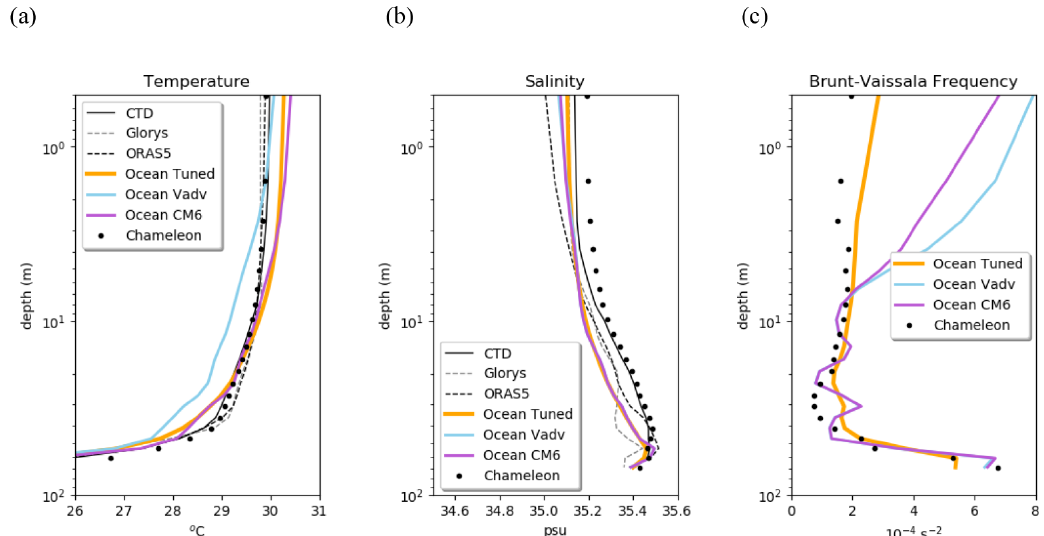
Figure 3. Mean vertical profile of (a) temperature ( ◦ C), (b) salinity (psu), and (c) the Brunt–Vaïsala frequency (10 − 4 s − 2 ) averaged over the simulated period (13–22